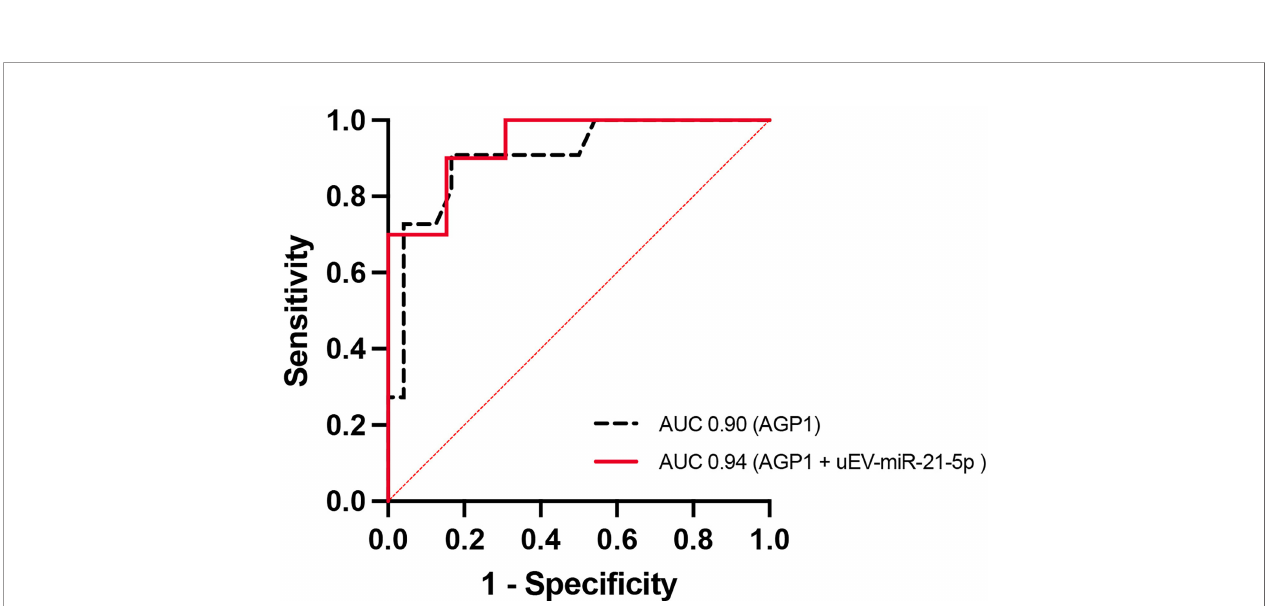
FIGURE 9 | Regression model and Receiver operating characteristic (ROC) curve. ROC curve for serum AGP1 levels (black) and serum AGP1 levels + uEVs associated miR-21-5p (red) can discriminate the PA condition from EH and CTL